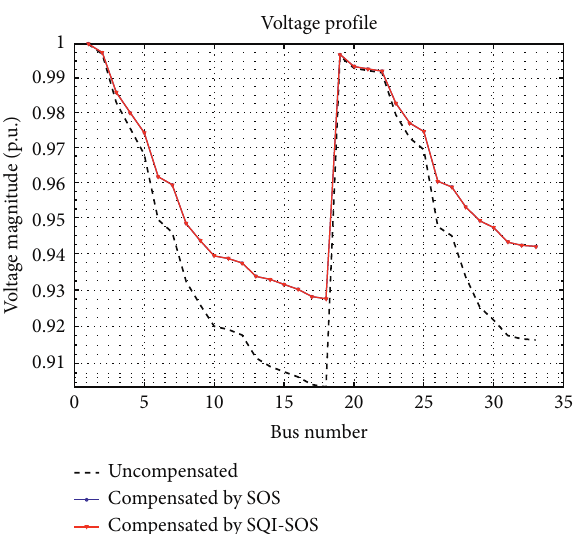
Figure 3: Voltage profile of the 33-bus system before and after compensation with the CP load model at 100%